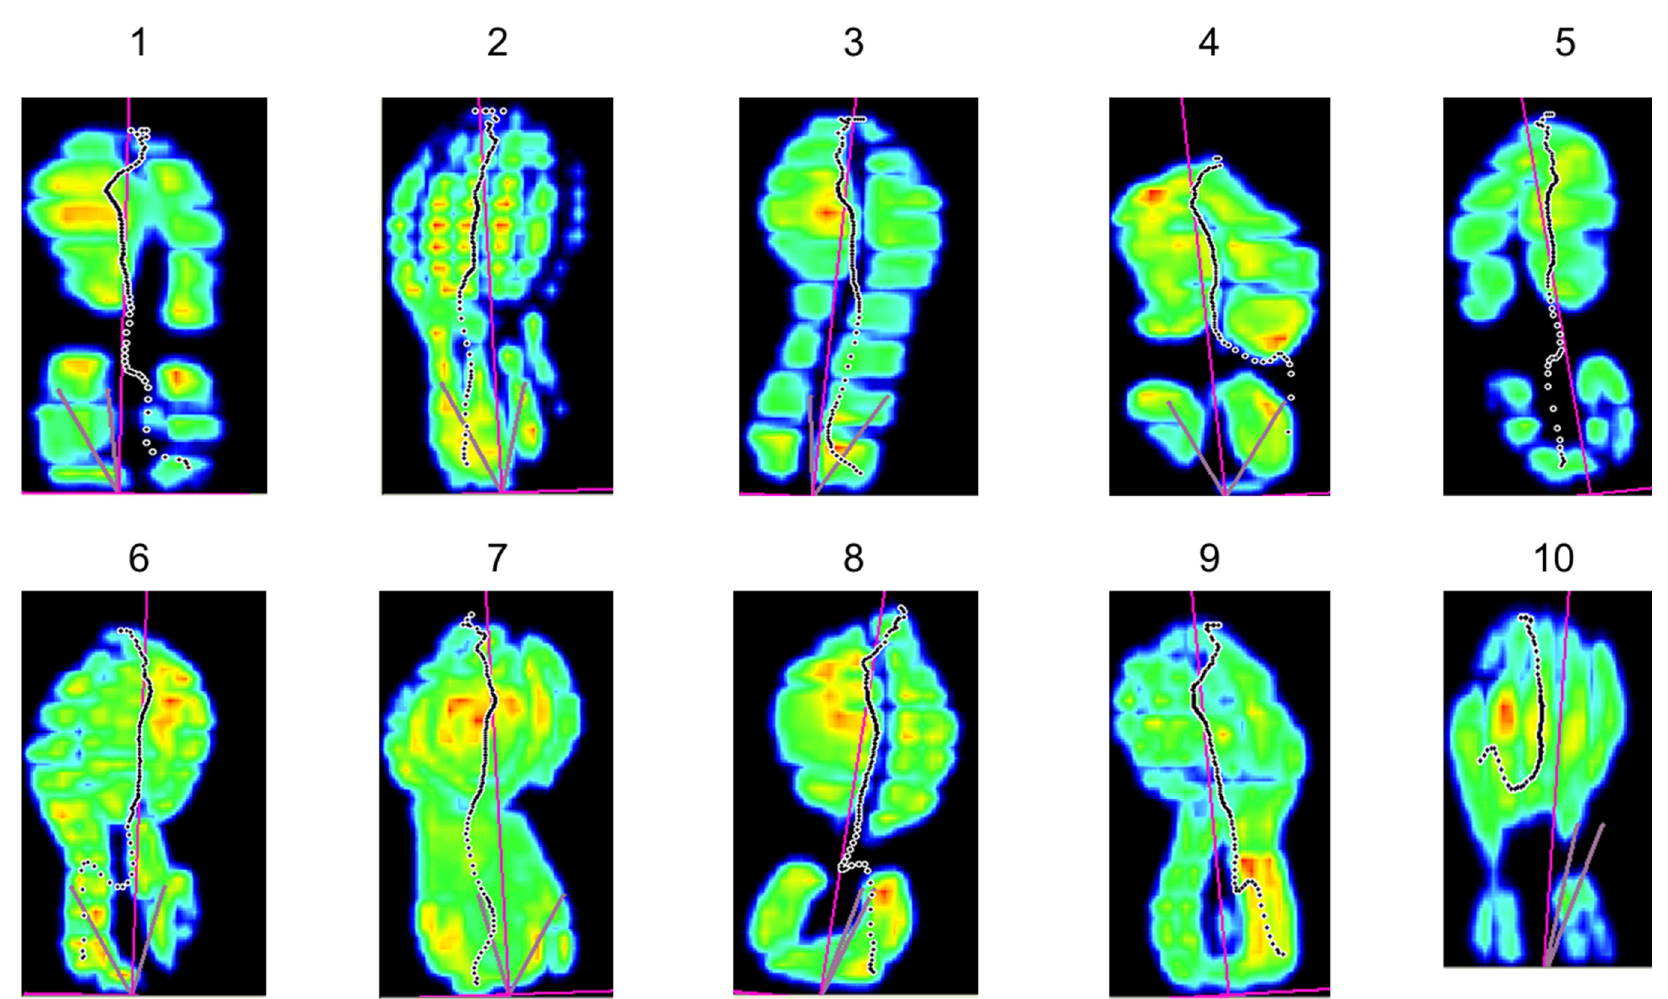
Figure A1 : A peak pressure footprint for each subject (numbered 1 to 10) in the no-biofeedback condition. The centre of pressure path is indicated as a dotted line.